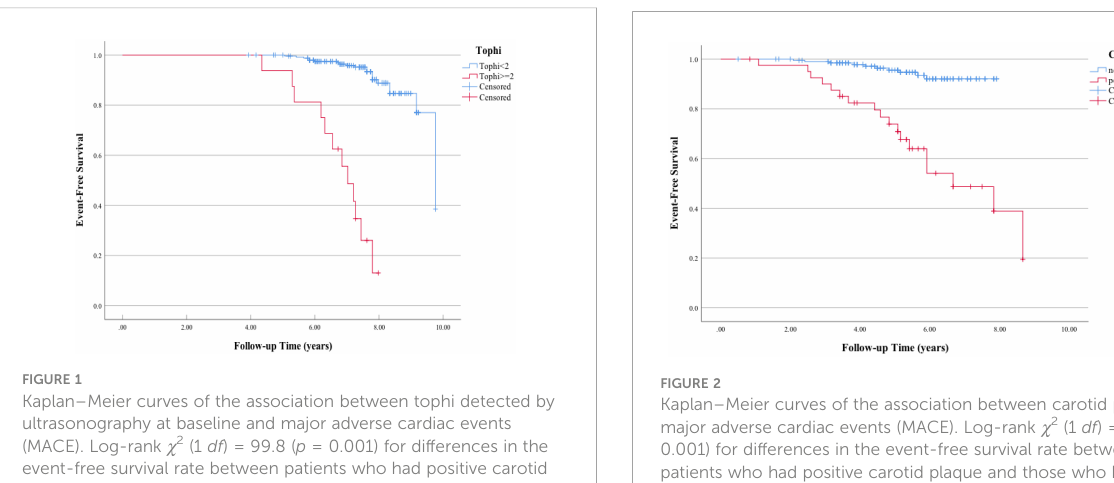
FIGURE 1 Kaplan – Meier curves of the association between tophi detected by ultrasonography at baseline and major adverse cardiac events (MACE). Log-rank c 2 (1 df ) = 99.8 ( p = 0.001) for differences in the event-free survival rate between patients who had positive carotid plaque and those who had negative carotid plaque.